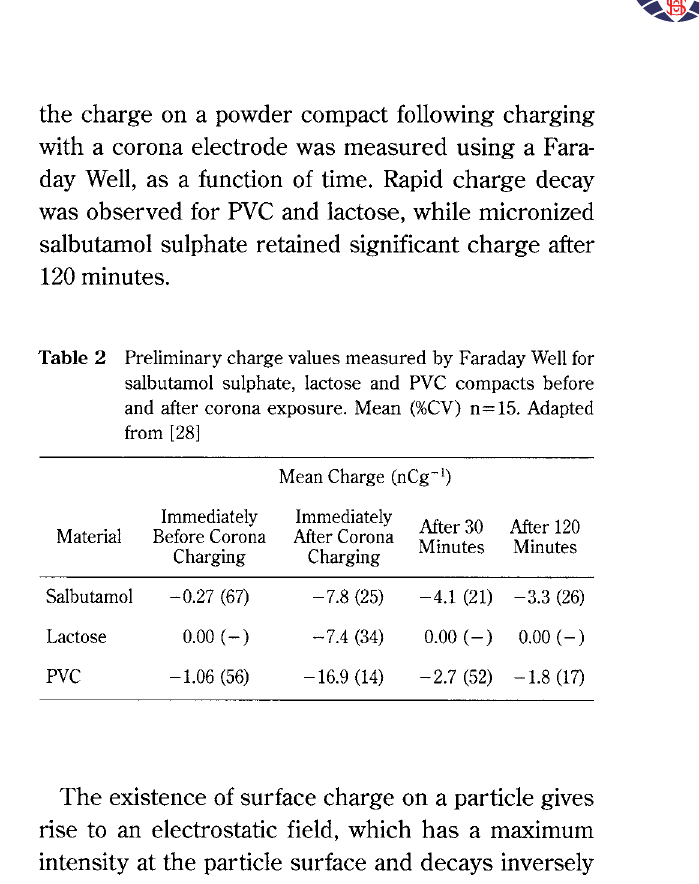
Table 2 Preliminary charge values measured by Faraday Well